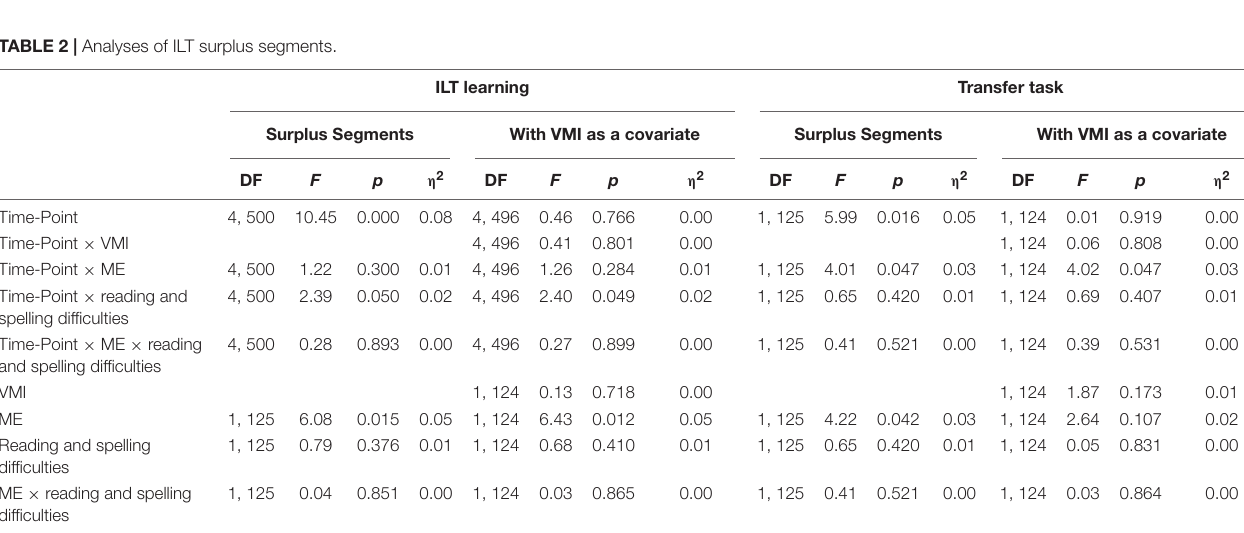
FIGURE 3 | ILT number of surplus segments (assessed as surplus hand raises, mean and standard deviation) among the four groups: HME typical learner , typical learner with high maternal education; LME typical learner, typical learner with low maternal education; HME reading and spelling difficulties , reading and spelling difficulties with high maternal education; LME reading and spelling difficulties , reading and spelling difficulties with low maternal education. The figure depicts the five points in time: TPI (Init Day 1 ) Initial Day 1: TP2 (End Day 1) end of Day 1, TP3 (24 h) post-training initial of Day 2, TP4 (End Day 2) end of Day 2; TP5 (2 Weeks) and 2 weeks post-training retention testing.